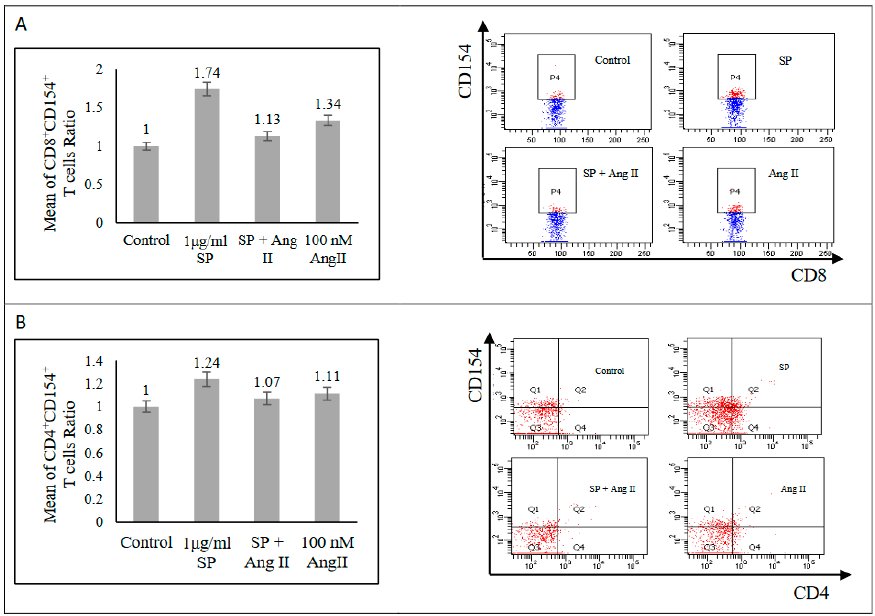
Figure 2. Activated T-cells surface markers of recovered COVID-19 patients. ( A ) Left: CD8+ CD154+ T-cells (n = 4). Right: FACS representative plot. ( B ) Left: CD4+ CD154+ T-cells (n = 4). Right: FACS representative plot. The ratio of T-cells responses was measured as the mean of the percentage of the cell surface marker-positive T-cells in each group to the percentage of the cell surface marker-positive T-cells in the control group after the stimulation of PBMCs with a SARS-CoV-2 peptide pool (SP), angiotensin II (Ang II), or both of a SP and Ang II.